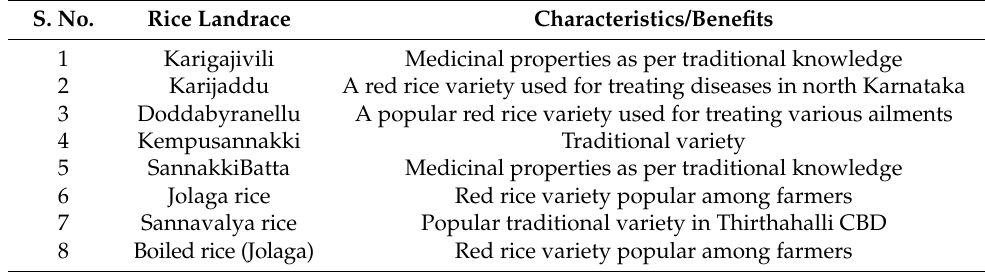
Table 4. Traditional rice varieties in Karnataka’s Western Ghats region. S.